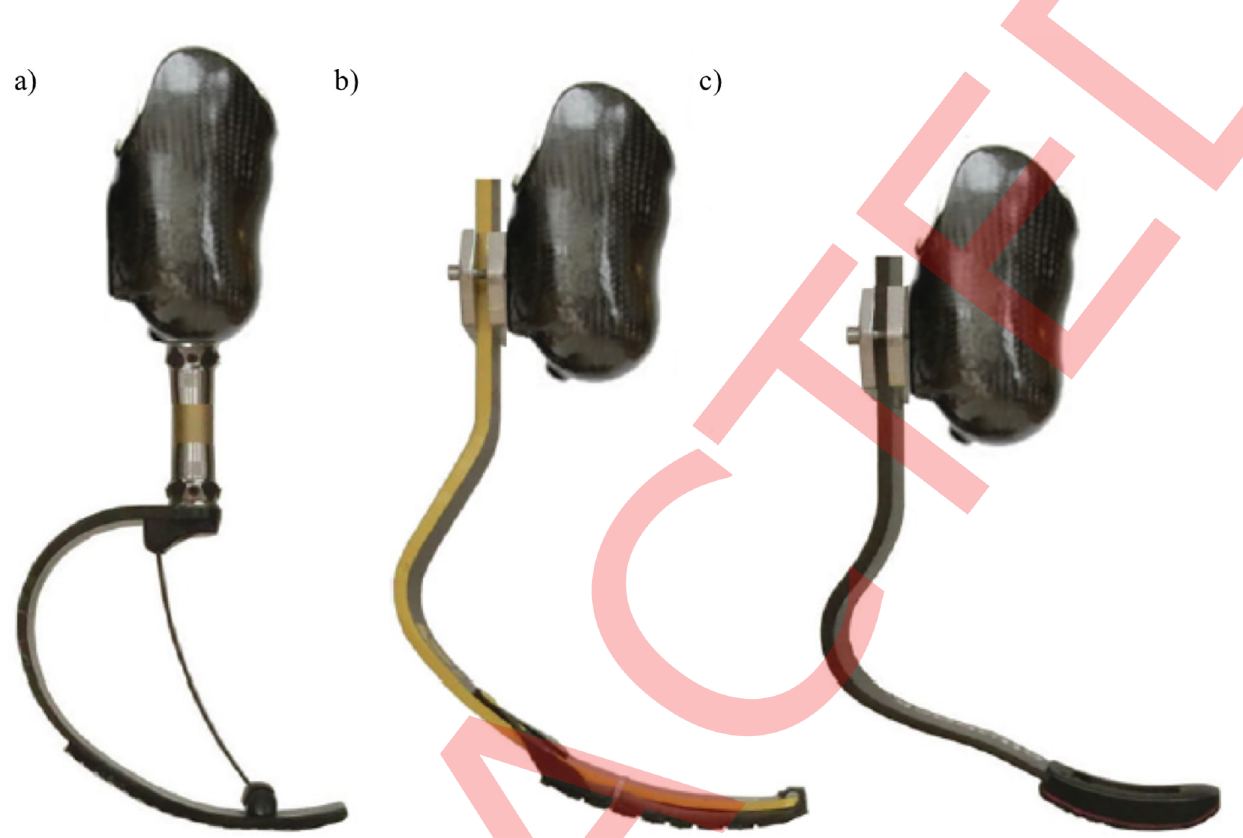
Fig 1. Three RSP models used in the study. a) Freedom Innovations Catapult FX6 (C-shaped) configured 2 cm taller than the International Paralympic Committee maximum allowable height (IPC max), b) O¨ssur Flex-Foot Cheetah Xtend (J-shaped) configured at the IPC max and c) Ottobock 1E90 Sprinter (J-shaped) configured 2 cm shorter than the IPC max.